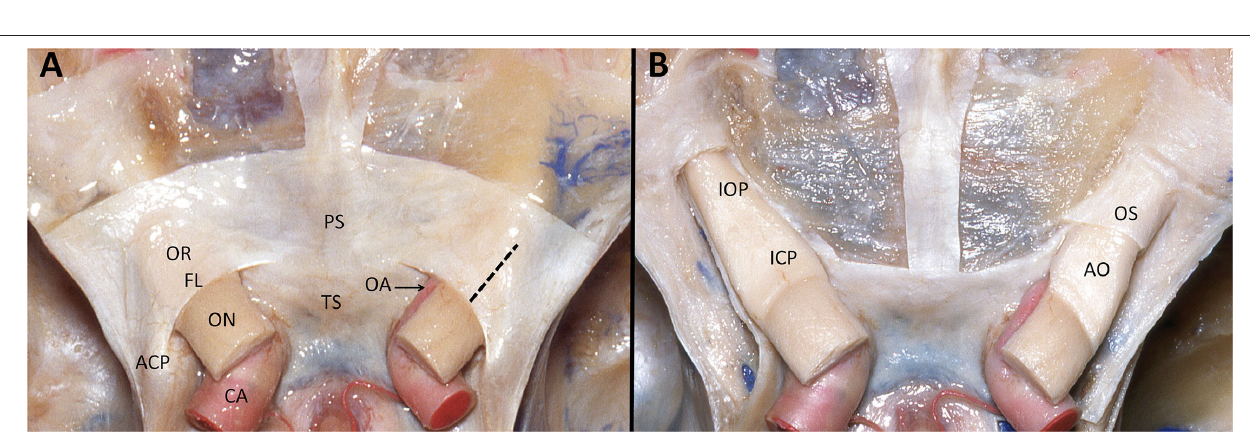
FIGURE 6 | (A) Superior view of anterior and middle skull base dissection showing both internal carotid arteries in the supraclinoid segment (C6). We can observe the dura covering both optic nerve canals with its posterior concave border represented by the falciform ligament. The intracranial optic nerves were sectioned in order to show the trajectory of the carotid arteries. Laterally to the optic nerves and the carotid arteries are located the anterior clinoid processes. In dotted line is marked the distance to the free edge of the falciform ligament that we use to perform de durotomy. (B) After removing the dura and unroofing both optic canals, on the right optic nerve is exposed the first layer that corresponds to the optic sheath and internally the arachnoid of the optic nerve. OR, Optic roof; FL, Falciform ligament; ON, Optic nerve; CA, Carotid artery; ACP, anterior clinoid process; PS, Planum Sphenoidale; TS, Tuberculum sellae; OA, Ophthalmic artery; Dotted line, distance to the free edge of the falciform ligament that we use to perform de durotomy; IOP, Intraorbital optic nerve; ICP, intracanalicular optic nerve; OS, Optic sheath; AO, Arachnoid of the optic